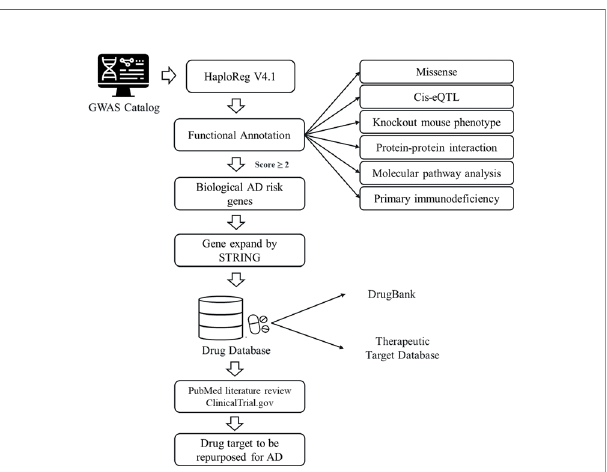
FIGURE 1 | An overview of drug repurposing for atopic dermatitis (AD). The study design utilizing by GWAS Catalog and various databases: DrugBank database, Therapeutic Target Database (TTD), ClinicalTrial.gov, and